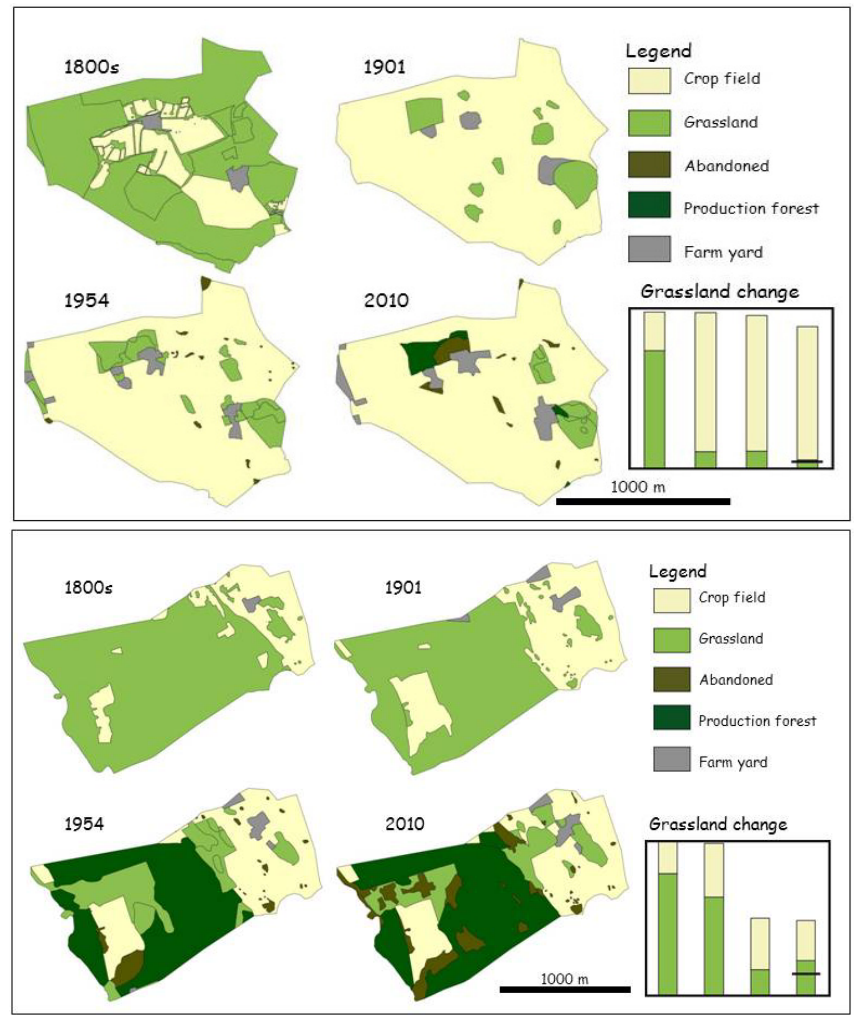
Figure 3. More than 200 years of land use change from two infield systems in south-eastern Sweden [49]. ( Top ) The top landscape, Kallmyra, is situated on mainly clayey soils where grasslands were turned into crop fields more than 100 years ago. Today this is a typical open Swedish agricultural landscape. The landscape at the bottom, Ettersta, represents a landscape that changed later, mainly in favor of forestry, when grasslands were abandoned or planted with coniferous forest 70 years ago. ( Bottom ) The staple diagrams show the change in grassland (green) and crop field (yellow) during the four time-steps, with the oldest to the left. The line crossing the grassland staple in the present-day landscape represents the proportion of old semi-natural grassland within the